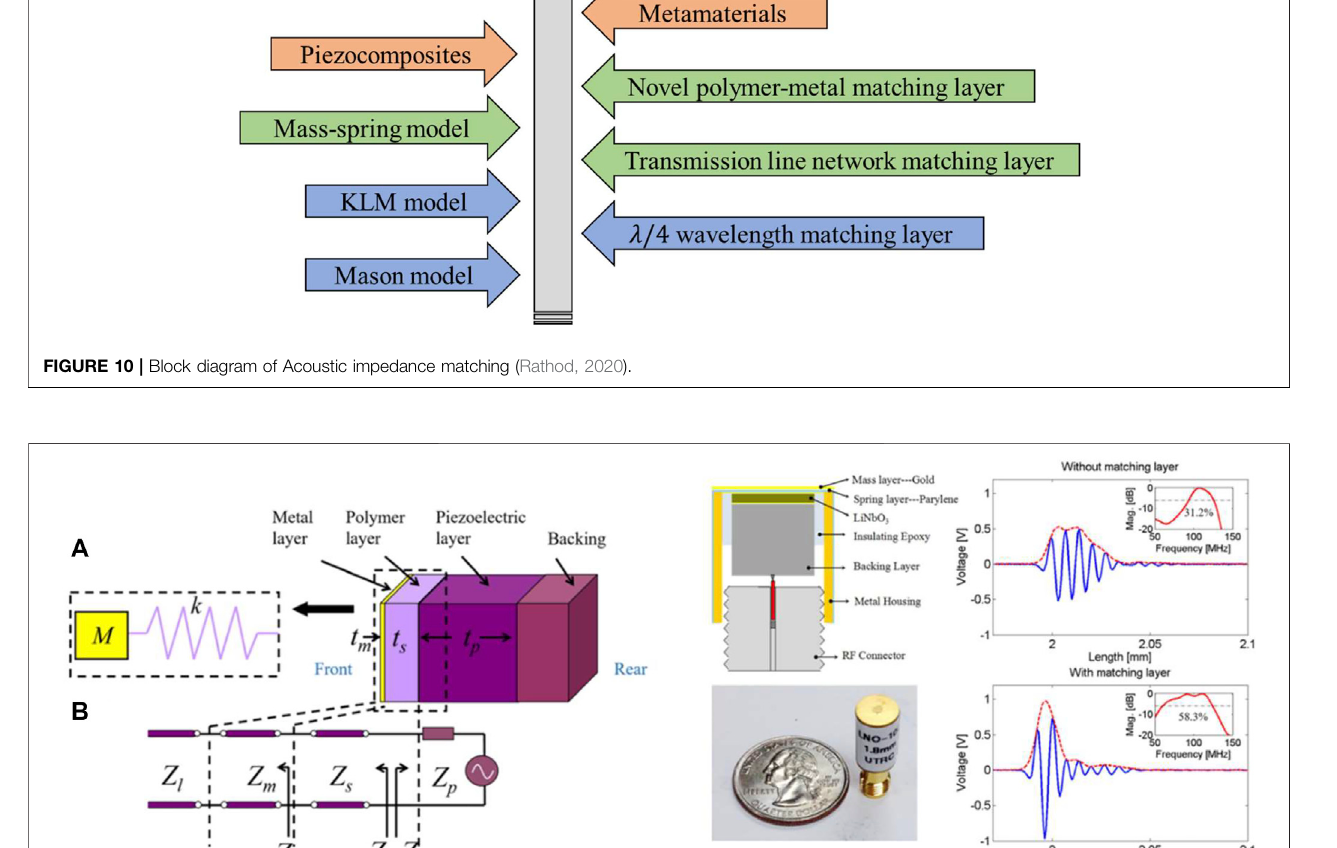
Frontiers in Materials |